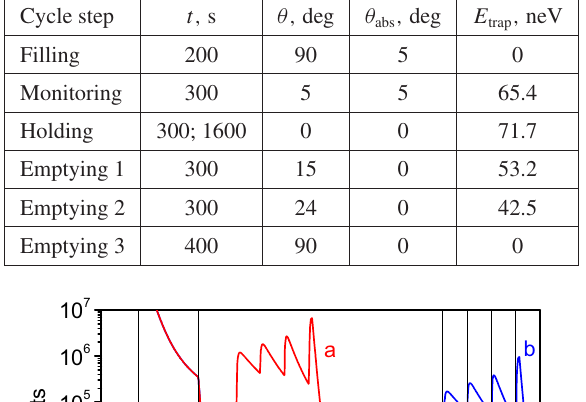
Table 3. Parameters of the measurement procedure with monitoring and with the absorber. E trap is the gravitational trap barrier at the quoted trap rotation angle θ .